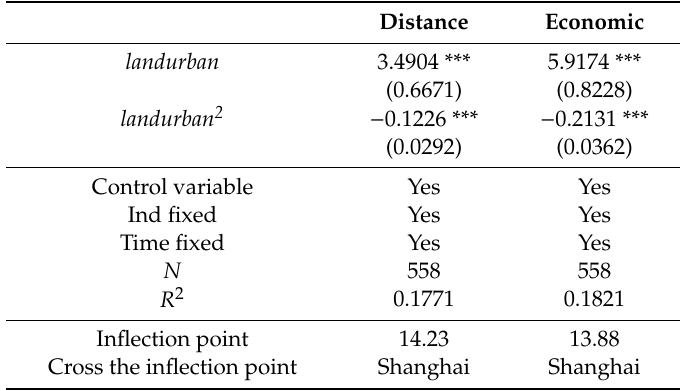
Table 6. SAR panel data model estimated results of di ff erent spatial weight